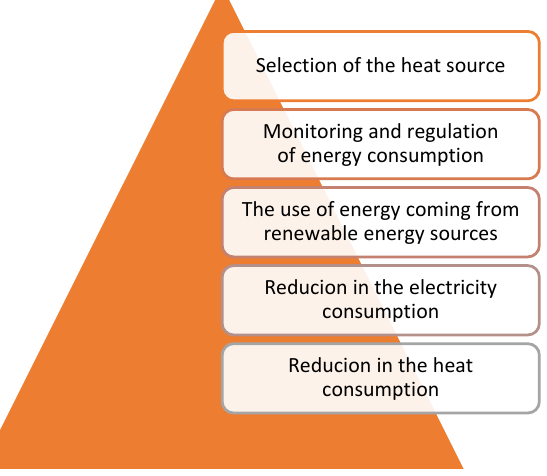
Figure 1. An example of a 5-step energy-saving pyramid.